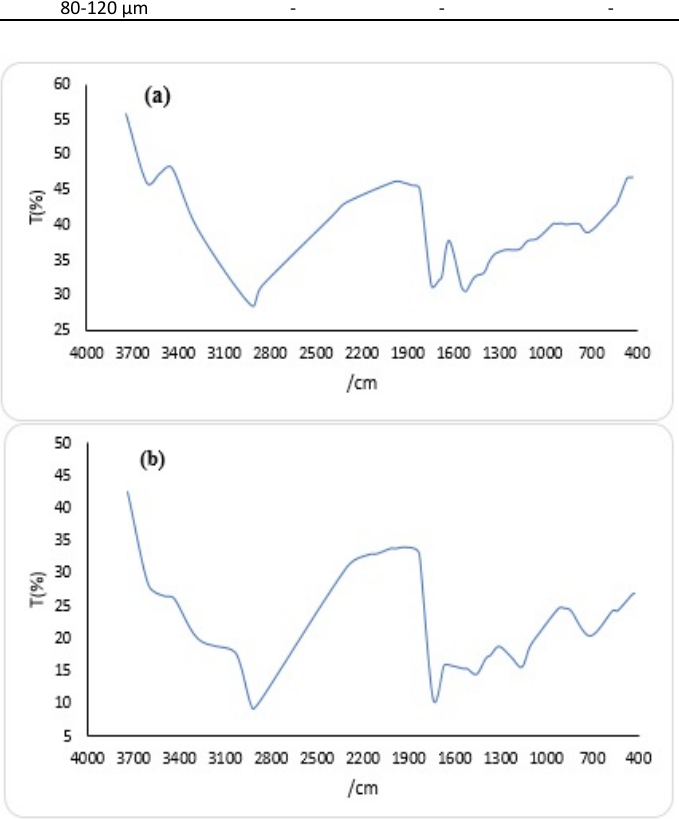
Fig. 2: The graph of the FT-IR analysis of carcass of (a) the mullet Mugil cephalus , and (b) bagok catfish Hexanematichthys sagor